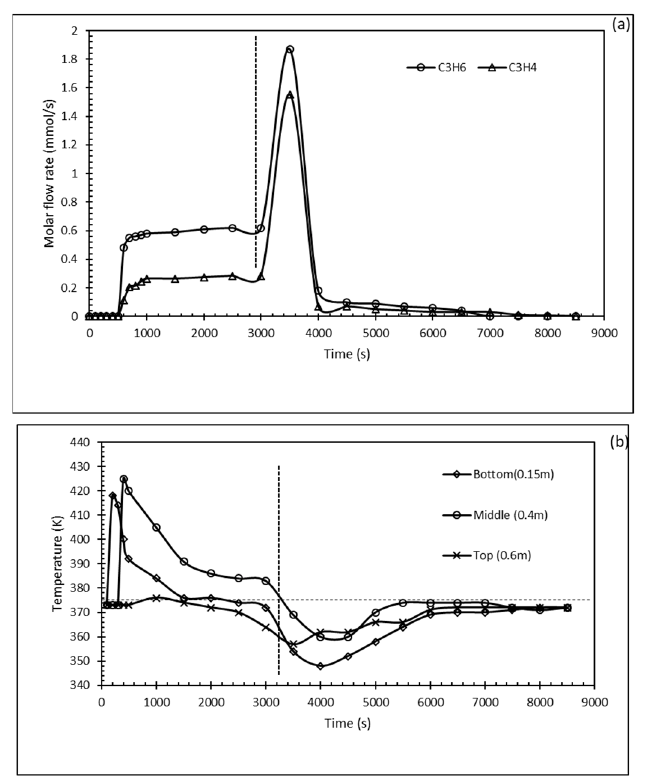
Figure 6. Dynamic breakthrough experiments temperature profile for a multi-component system (30:70% v / v propyne/propylene); ( a ) molar flow rate with time; ( b ) temperature profile in the fixed bed column.